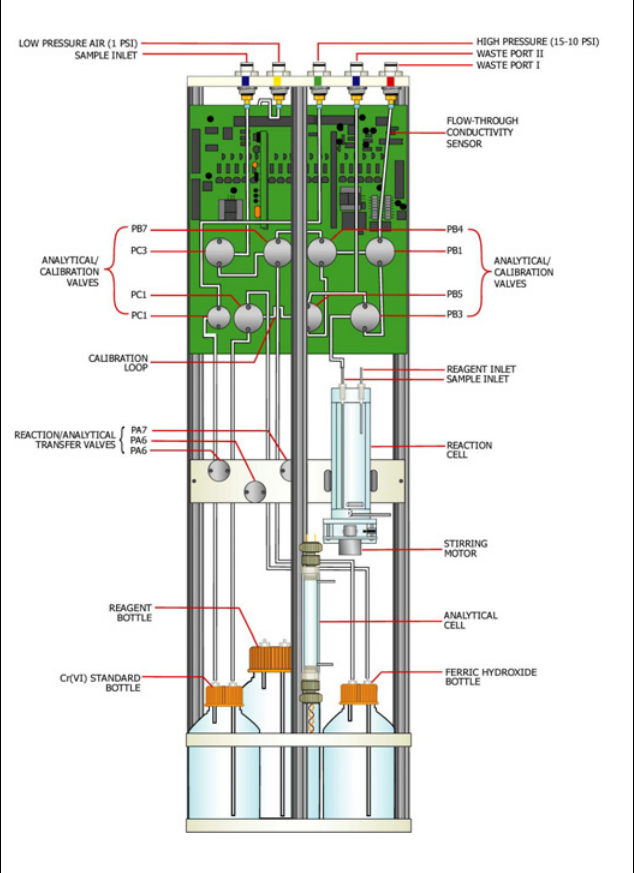
Figure 4. Schematic of analytical / calibration